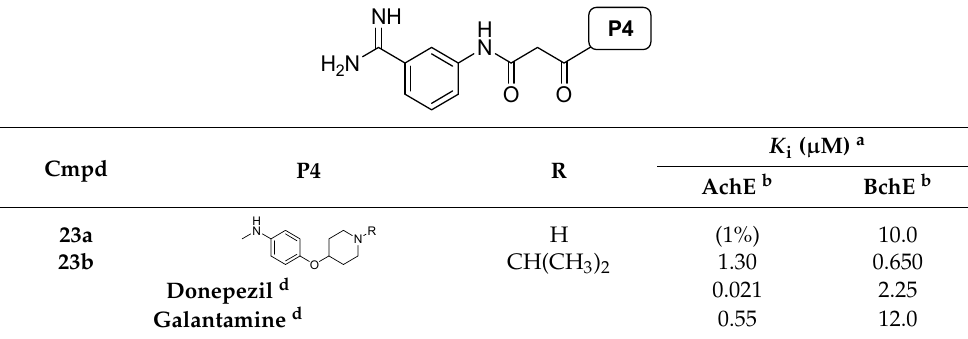
Table 5. Cont. Table 5. Inhibitory activity of selected malonamides on cholinesterases (eeAChE,